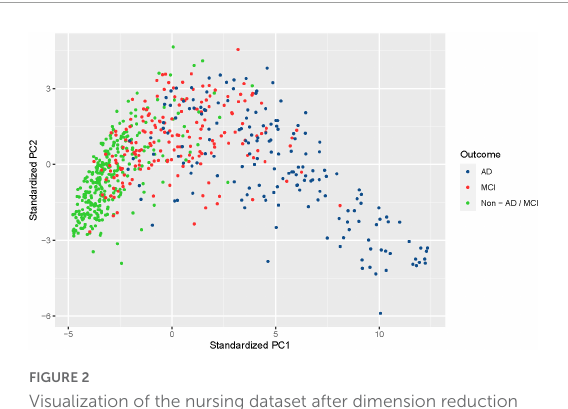
FIGURE2 Visualization of the nursing dataset after dimension reduction with principal component analysis. Black dots represent patients diagnosed with Alzheimer’s disease (AD), red dots represent patients diagnosed with mild cognitive impairment (MCI), and green dots represent patients from neither class